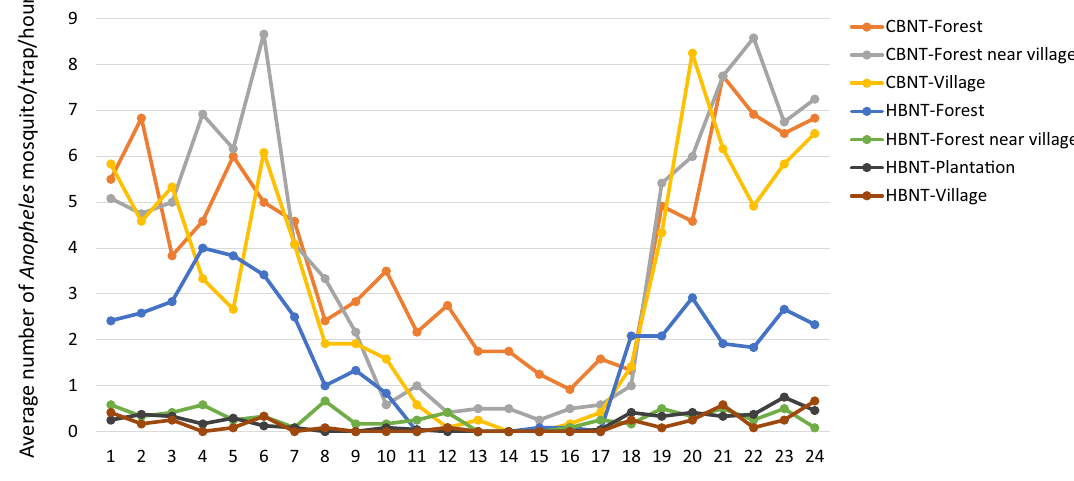
Figure 2. Average number of Anopheles females collected per trap per hour in the different collection sites in the HBNTs and the A total of 3131 females were morphologically identified as 14 different Anopheles species or complexes of morphologically indistinguishable sibling species. Based on these morphological identifications, species thought to be primary vectors comprised only 10.2% of the collected mosquitoes: Anopheles dirus s.l. (8.1%, n = 319), A. minimus s.l. (0.4%, n = 15) and A. maculatus s.l. (1.7%, n = 67). The most abundant species (represented by more than a hundred individuals in our collection) constituted 75.8% of the collected Anopheles mosquitoes and were represented by 6 species complexes: A. barbirostris (21.2%, n = 831), A. philippinensis (14.6%, n = 571), A. hyrcanus (13.6%, n = 535), A. kochi (10.5%, n = 412), A. dirus (8.1%), A. aconitus (7.7%, n = 303). Molecular determination of mosquito species. A total of 844 females were molecularly characterized for species in the random subset and represent 26 distinct Anopheles species as determined by ITS2 and CO1 (Table S2). The most abundant species (representing ≥ 5% of the samples; n ≥ 42) comprise 77.8% of the molecu- larly typed individuals and represent 8 species from 6 different species complexes. These most abundant species included A. dirus (13.2%, n = 112) from the Dirus complex. From the Barbirostris complex; A. dissidens (13.2%, n = 112), and A. campestris-wejchoochotei (8.1%, n = 69). From the Hyrcanus Group, A. peditaeniatus (12.8%, n = 108), and A. nitidus (5.7%, n = 48). The Annularis, Funestus, and Kochi Groups were each represented by a single species A. nivipes (9.2%, n = 78), A. aconitus (6.7%, n = 57), and A. kochi (8.7%, n = 74), respectively. The 18 less abundant species, represent by fewer than 42 samples and in many cases just a handful of samples included A. philippinensis (n = 17) and A. annularis (n = 1) from the Annularis Group, A. jamesii (n = 16), A. pseudojamesi (n = 1), and A. splendidus (n = 1) from the Jamesii Group and A. saeungae (n = 29) and A. barbirostris (n = 2) from the Barbirostris Group. From the Hyrcanus Group A. crawfordi (n = 40), A. argyropus (n = 1), An. nigerrimus (n = 28), and A. sinensis (n = 3) were sampled. Anopheles maculatus (n = 22), A. sawadwongporni (n = 4), and A. rampae (n = 2) from the Maculatus Group. Anopheles tessellatus from the Tessellatus Group and A. interruptus from the Asiaticus Group were each sampled once. A. vagus (n = 12) and A. karwari (n = 3) were also present. There were 2 mosquitoes that had 99.9% identical ITS2 and 99.4% identical CO1 sequences but matched no spe- cies in the NCBI database. In addition to the random subset, 79 Plasmodium sp . infected samples were molecu- larly characterized for species which resulted in a total of 29 Anopheles species as determined by ITS2 and CO1. Day biting rate. Overall 20.2 ± 1.2% of the Anopheles females were captured during the daytime (between 06:00 and 18:00). Indeed, while the majority of Anopheles mosquitoes bite at night, an important proportion was active during the day (Fig. 2). Excluding species with extremely low sample sizes and unidentified samples, day biting behaviour was observed for all the Anopheles species and varied from 13 to 68% (Table S3). The day biting rate in the HBNTs was not different across collection sites (19.6 ± 2.9%; χ 2 = 3.6, df = 3, p = 0.3; Fig. 3a) but was higher during the dry season (25.9 ± 4.6%) compared to the rainy season (13.8 ± 3.5%; χ 2 = 19.08, df = 1, p < 0.001). There was an overall trend for a higher day biting rate during the dry season compared to the rainy season for all sites except in the forest near the villages where an opposite tendency was observed, however the interaction between collection sites and seasons was not significant ( χ 2 = 7.5, df = 3, p = 0.057). The day biting rate in the CBNTs was higher during the dry season (37.7 ± 3.3%) compared to the rainy season (14.5 ± 1.4%; χ 2 = 115.53, df = 1, p < 0.0001). There was no significant difference across the collection sites (20.4 ± 1.4%; χ 2 = 0.65, df = 2, p = 0.72; Fig. 3b) nor of the interaction between collection sites and seasons ( χ 2 = 1.97, df = 2, p = 0.37).